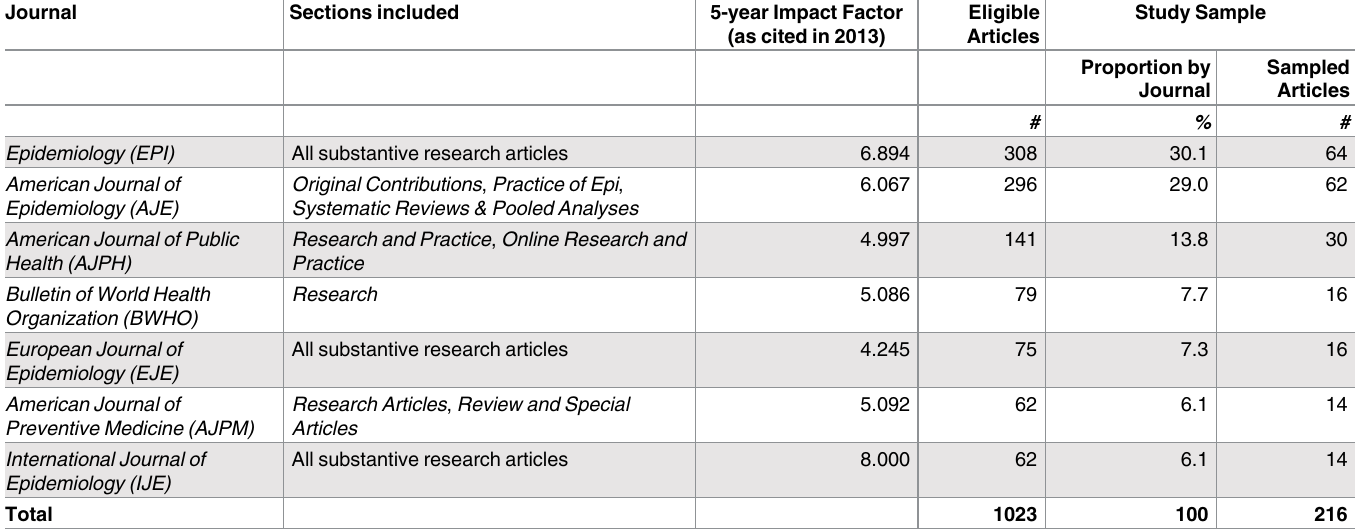
Table 1. Public health journals reviewed and number of articles from 2013 included in the study